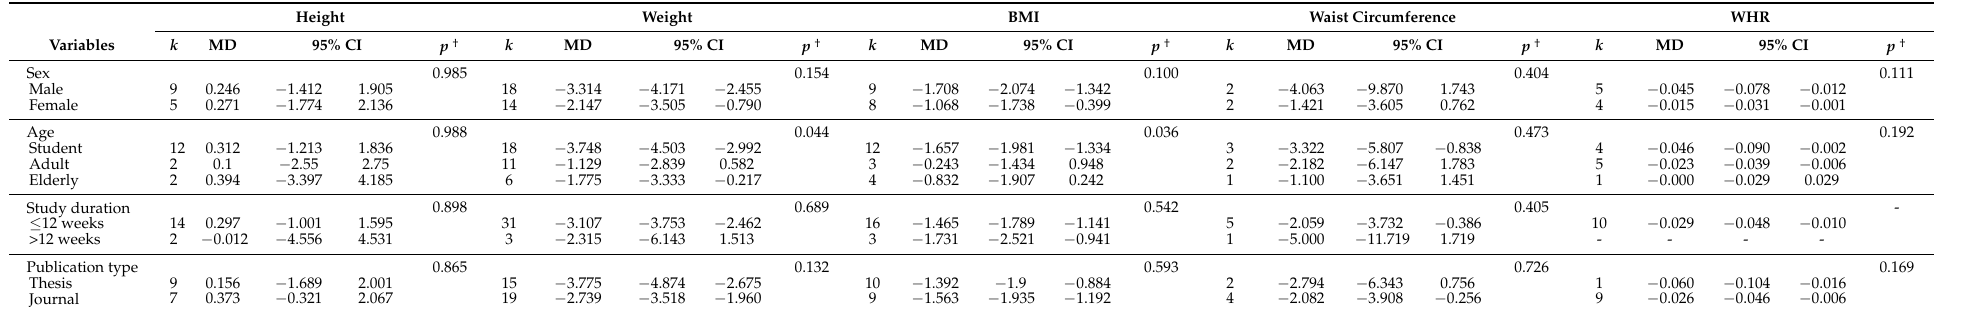
Table 2. Effects of moderators on height, weight, BMI, WC, WHR.